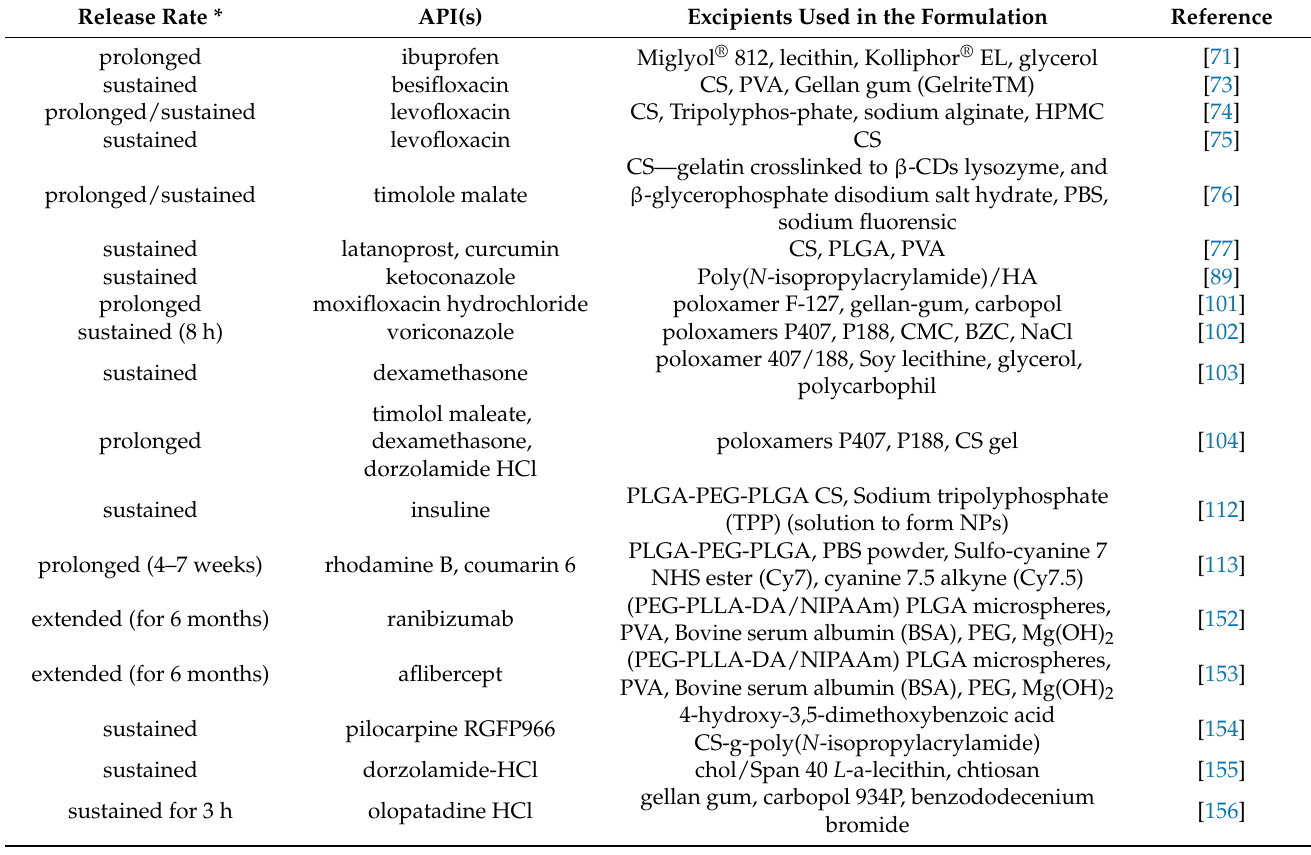
Table 2. An overview of the excipients used in modified release semisolid ocular formulations (gels, hydrogels, and creams).